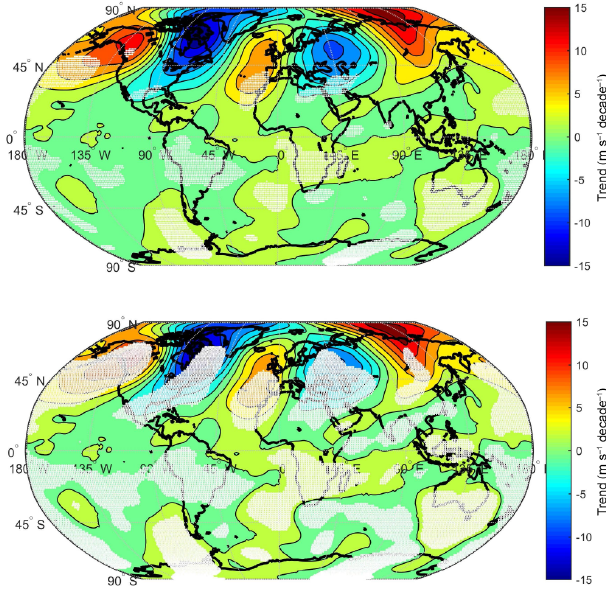
Figure 15. Meridional wind trends (ms − 1 decade − 1 ) for January at 10hPa from MERRA reanalysis for 1979–1997. Statistical signifi- cance (95%) is highlighted by white crosses on the top panel and significance (90%) on the bottom